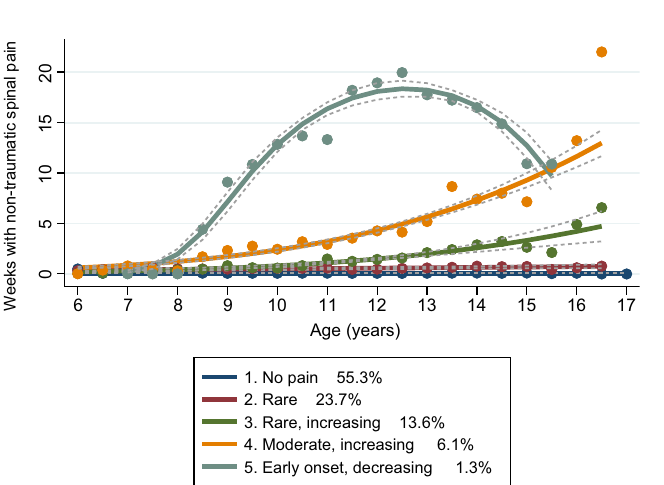
Figure 1. Participants flow diagram of participants with valid non-traumatic spinal pain and hs-CRP data from the CHAMPS Study-DK.